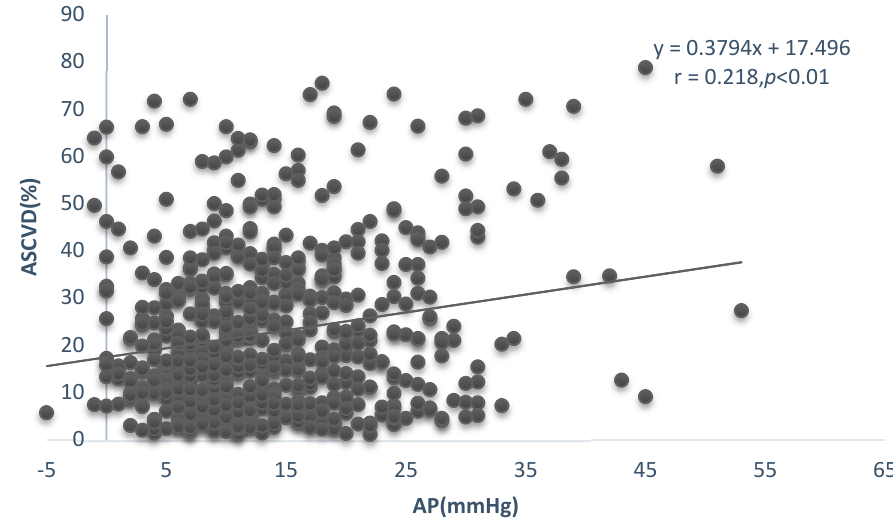
Figure 2. Linear relationship between aortic SBP and ASCVD.